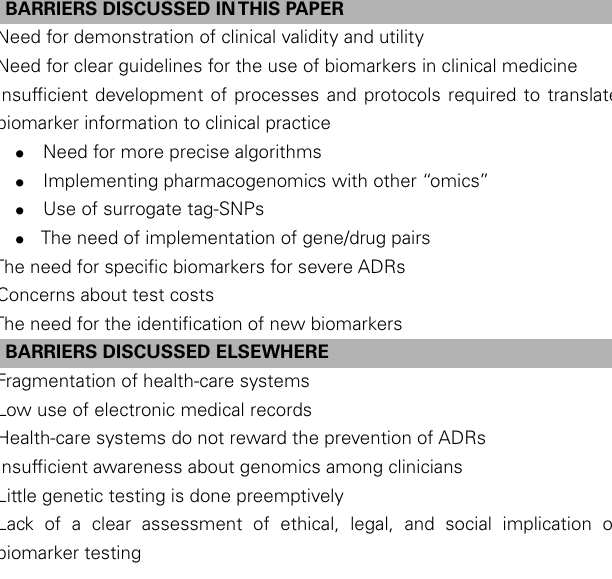
Table 1 | Examples of barriers to implementing individualized